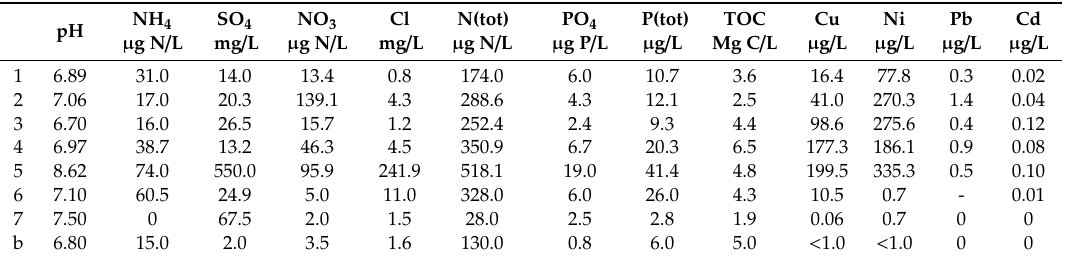
Table 1. Selected average chemical parameters (2016–2017) of the water bodies under non-ferrous